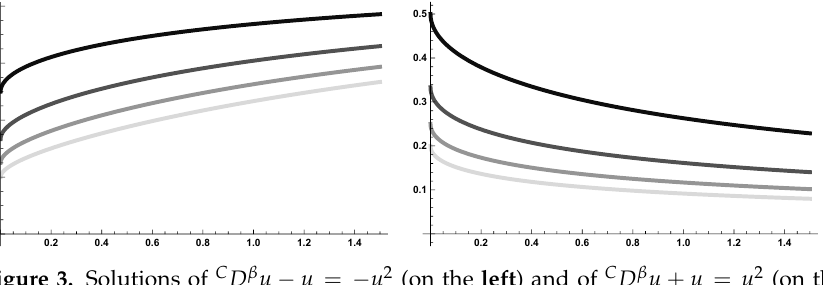
Figure 3. Solutions of C D β u − u = − u 2 (on the left ) and of C D β u + u = u 2 (on the right ) with β = 1/2 and u 0 = 1/2,1/3,1/4,1/5. Darker lines correspond to bigger u 0